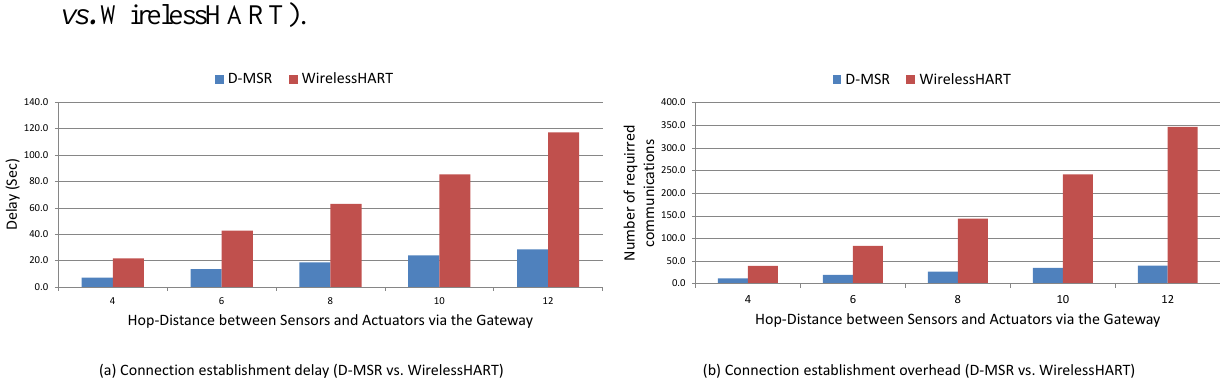
Figure 31. End-to-end connection establishment delays ( a ) and overhead ( b ) (D-MSR vs. WirelessHART).